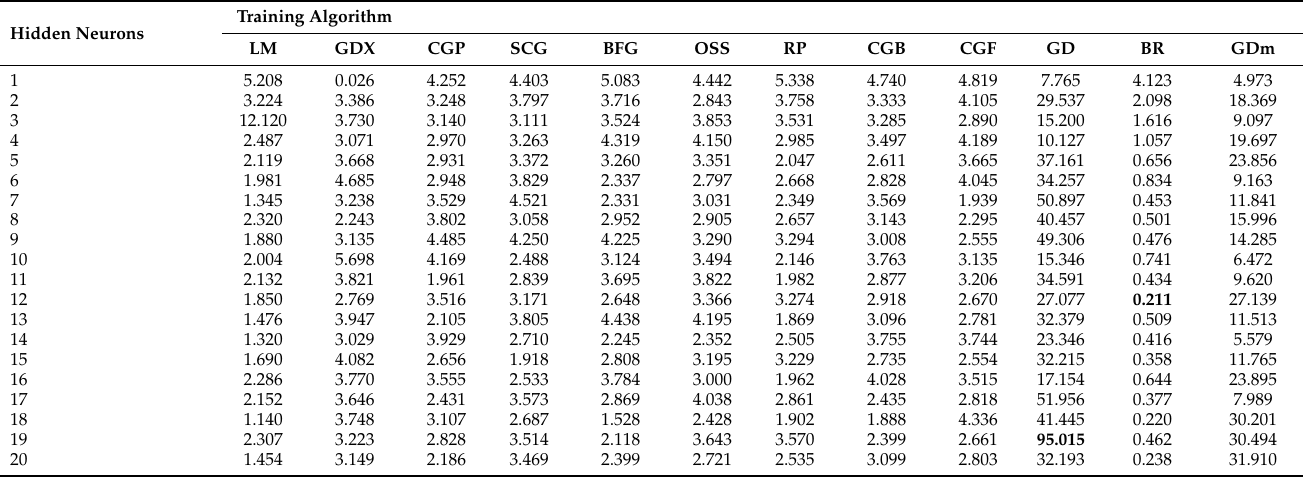
Table A8. MAE for COD removal (%) for different training algorithms at different number of hidden